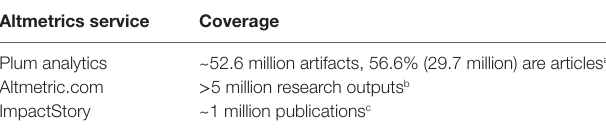
Table 1 | Coverage of major altmetrics